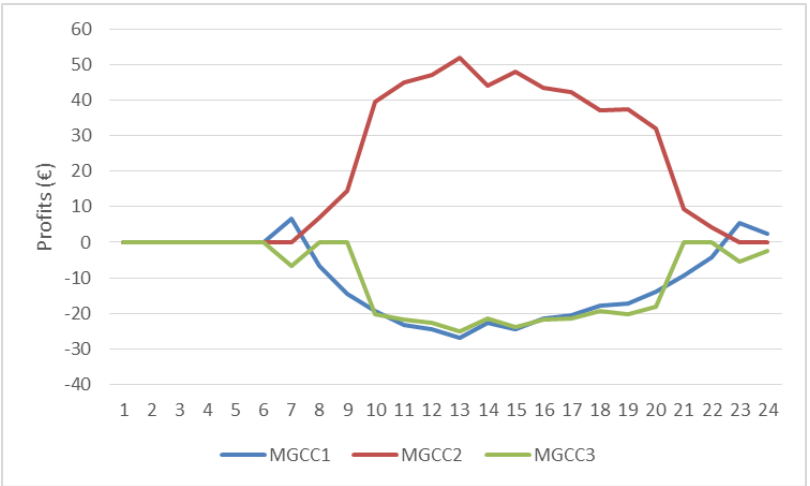
Figure 6. Profits achieved by the three MGCC in the second level of negotiations.